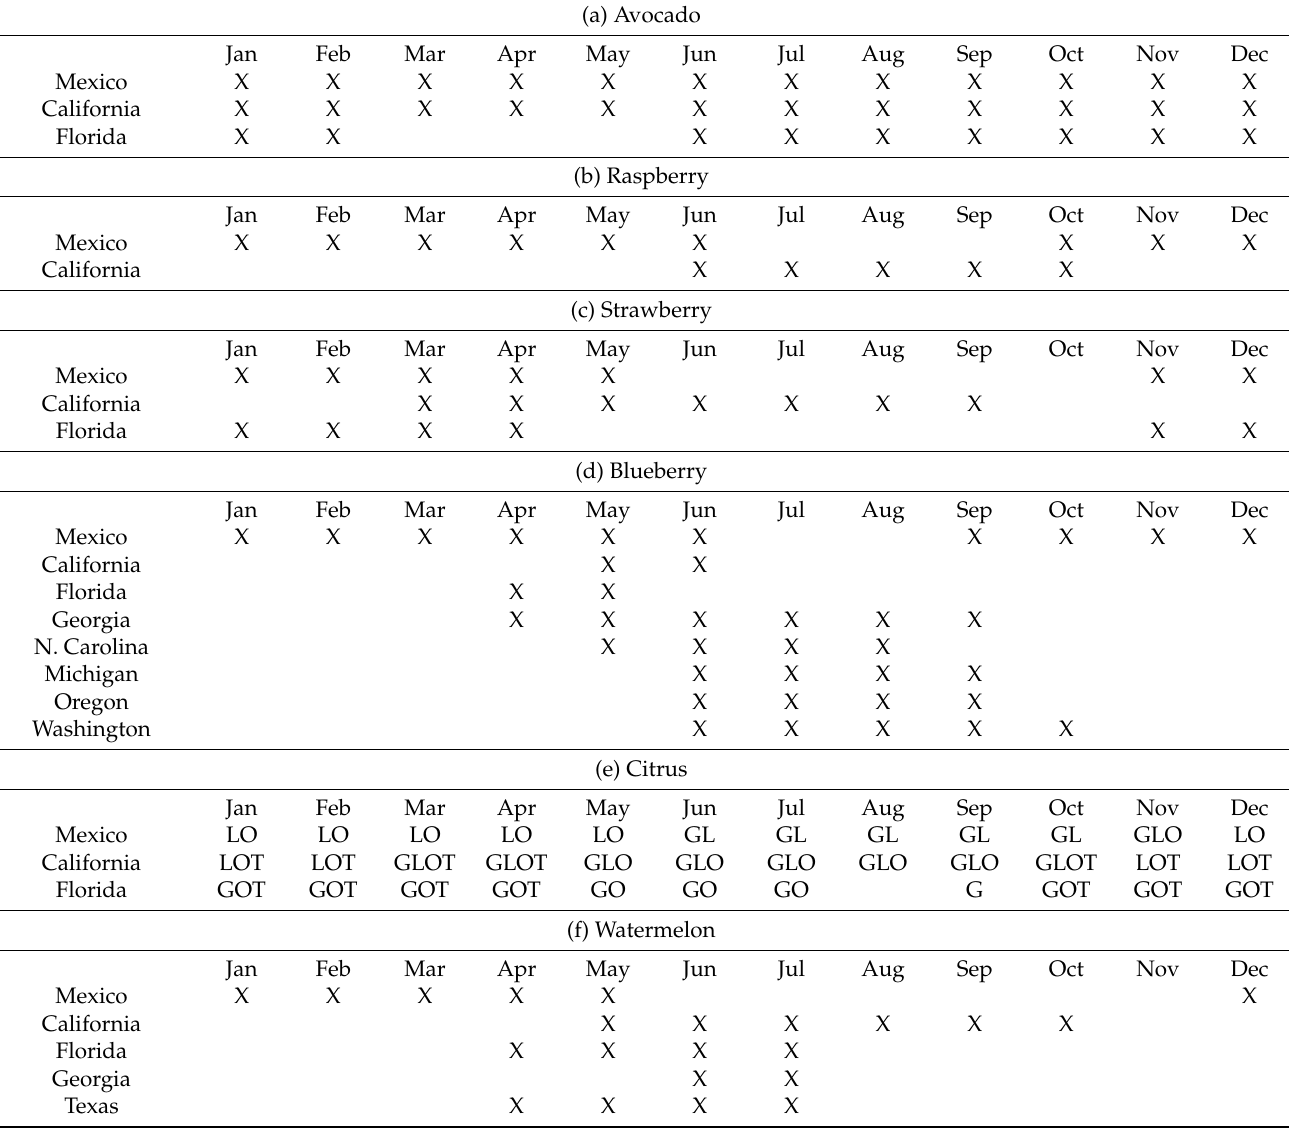
Table A1. Fruit harvesting calendars of major U.S. producing states and